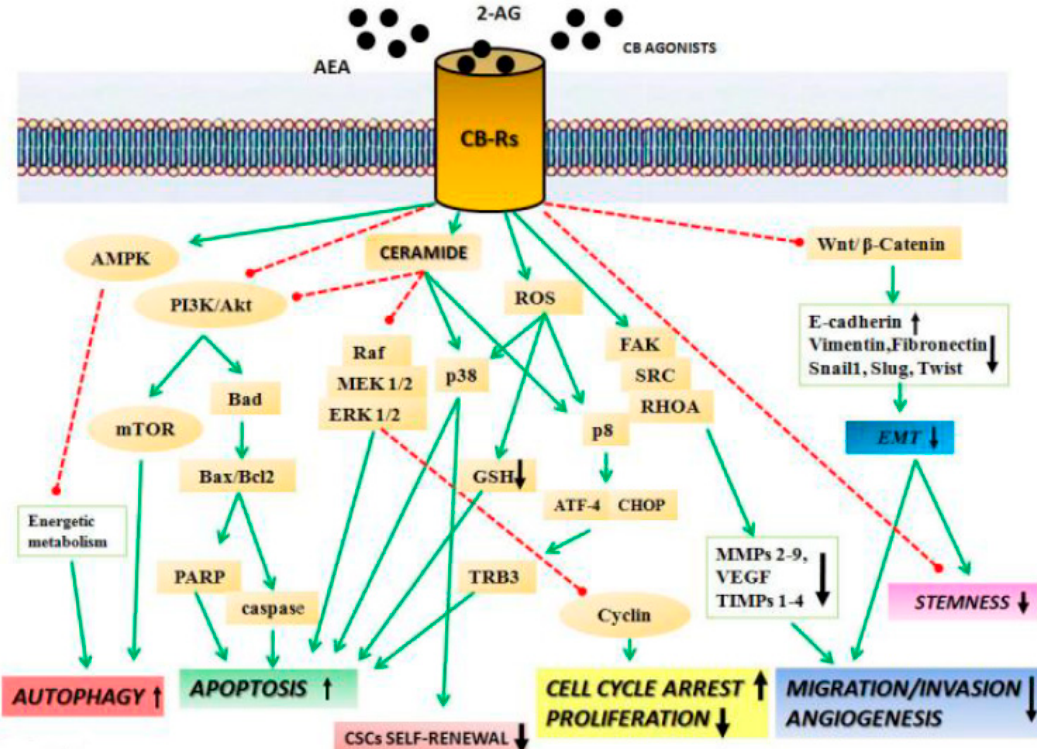
Figure 1. Schematic representation of the main anticancer molecular mechanisms mediated by cannabinoid receptors’ activation “ ↑ , upregulation” and “ ↓ , downregulation”. Cannabinoid receptor (CB-R) agonists inhibit cancer cell proliferation through various receptor-mediated mechanisms. CB-R agonist induces cancer cell death via apoptosis, mediated by the activation of di ff erent transcription factors (proapoptotic Bcl2 family transcription factor and mitogen-activated protein kinase (MAPK) pathway) and de novo synthesis of ceramide and reactive oxygen species (ROS) production. CBs block cancer cells’ proliferation by inhibiting extracellular signal regulated kinase (ERK) signaling. They also reduce cell migration and angiogenesis, inhibiting the focal adhesion kinase / proto-oncogene tyrosine-protein kinase Src / transforming protein RhoA (FAK / SRC / RhoA) pathway. CBs prevent cancer epithelial mesenchymal transition (EMT), inhibiting Wnt / β -catenin pathway, and induce autophagy by activation of mammalian target of rapamycin (mTOR) and AMP-activated protein kinase (AMPK) pathways. CBs can impair stemness and cancer stem cells’ (CSCs) self-renewal. (Akt (protein kinase B), PI3K (phosphoinositol-3-kinase) Raf (serine / threonine-protein